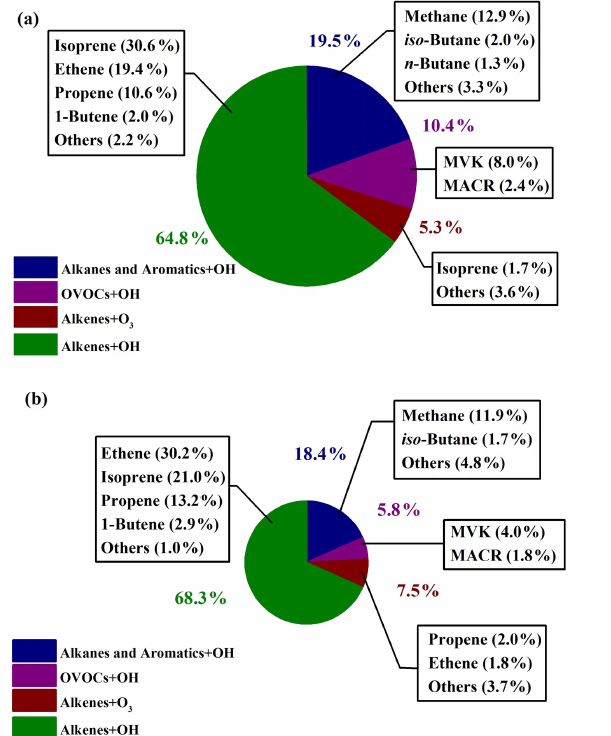
Figure 7. Relative contributions to HCHO production rates in (a) the sunny period and (b) the cloudy and rainy period. The rel- ative contributions to HCHO production are shown for the top 10 VOC species in each period. The area of pie charts is in proportion to the calculated HCHO production rates in two